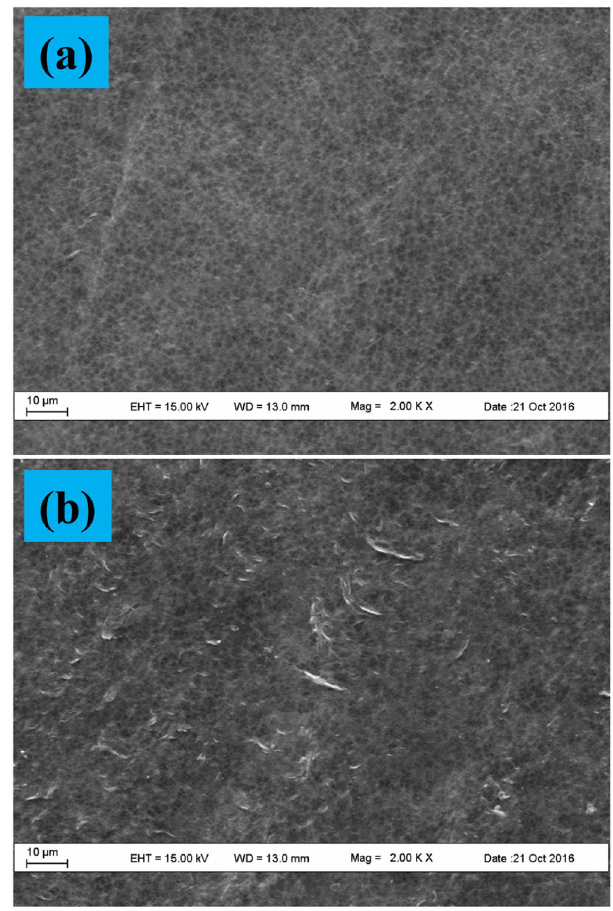
Figure 4. SEM images of the control and grafted membranes: ( a ) the control membrane; ( b ) the grafted